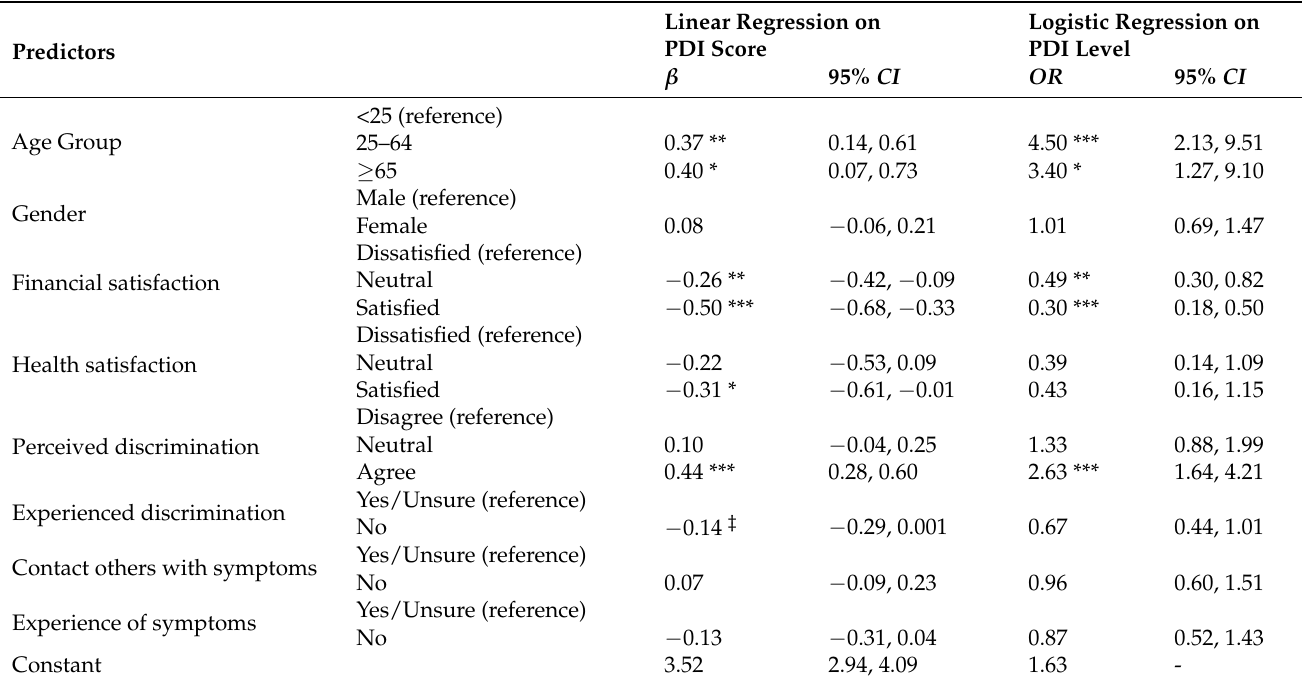
Table 3. Regression models on the Sociodemographic Predictors for PDI score and PDI level (“high distress” vs. “low